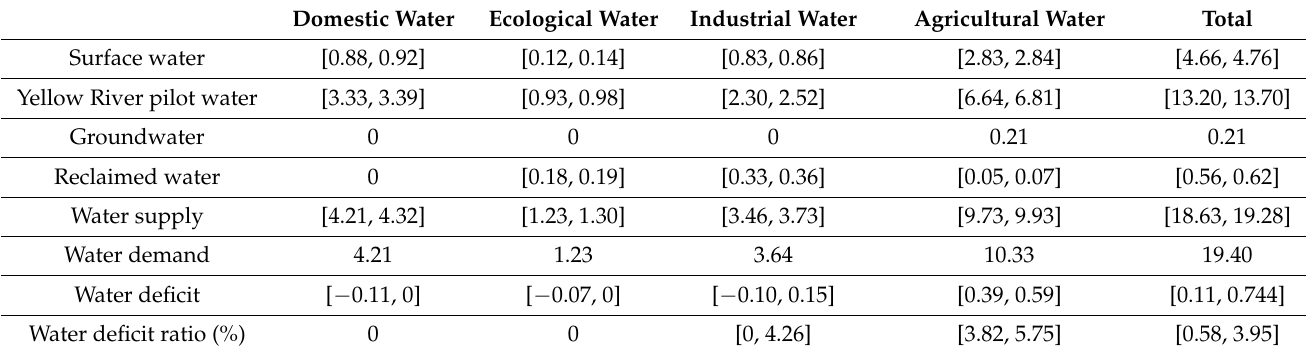
Table 6. Harmonious water resource allocation results for 2035 ( × 10 8 m 3